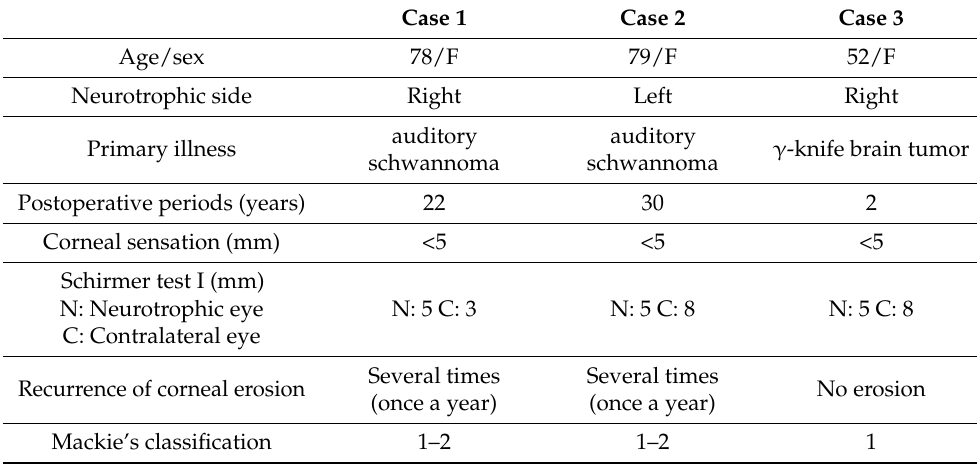
Table 1. Patients’ background and clinical